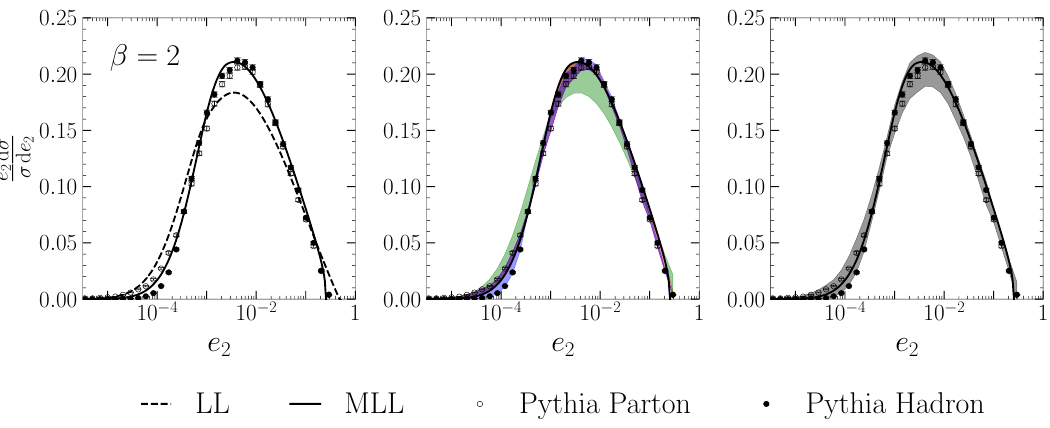
Figure 1 . Illustration of the enveloping procedure utilized to estimate theory systematic errors in this paper as applied to QCD, for p T = 1 TeV jets. The analytic and numerical predictions for the e 2 distributions are shown assuming various levels of approximation as detailed in the legend [left panel]. 8 These predictions are used to create error sub-envelopes [middle panel] that are then combined to result in the final envelope [right panel]. The green sub-envelope captures the difference between the LL and MLL analytic predictions The red sub-envelope captures the difference between the MLL analytic prediction and the parton level numerical result from Pythia . The blue sub- envelope captures the difference between the parton and hadron level prediction from Pythia . These envelopes are added in quadrature to compute the total envelope [right panel]. Note that when computing envelopes for the dark sector, we include three numerical predictions when the final states are dark partons, dark hadrons, or visible hadrons. The angular dependence parameter is set to (cid:12) = 2 for